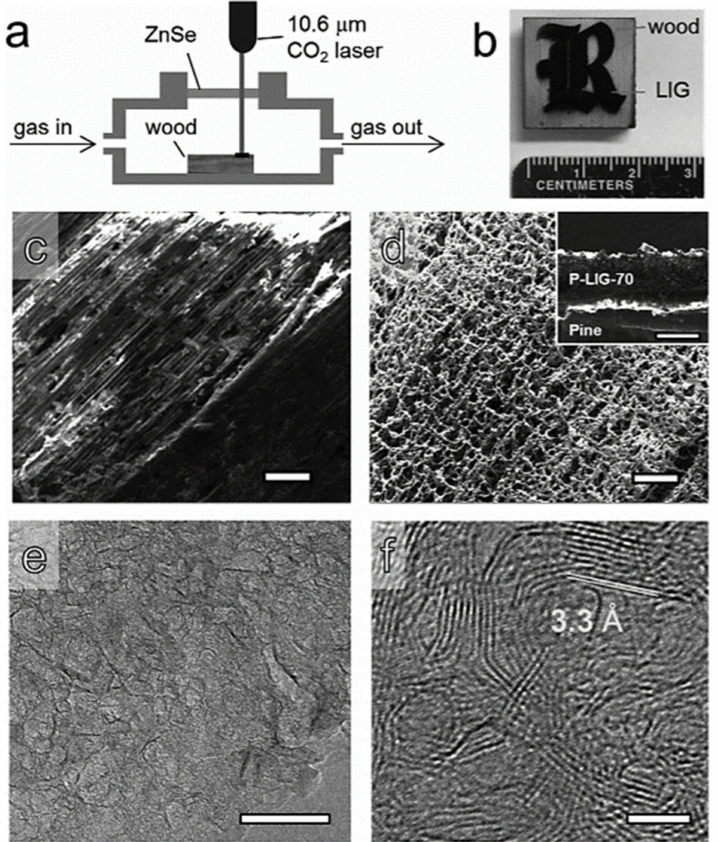
Figure 4. Schematic illustration of laser-induced graphene synthesis ( a ); The pattern of pine etched by the CO 2 laser ( b ); The SEM ( c,d ) and TEM ( e , f ) of P-LIG-70